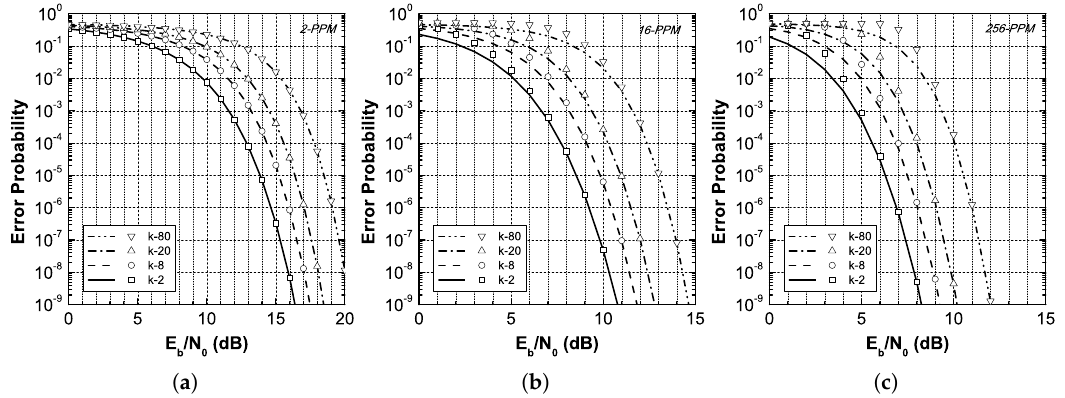
Figure 2. Probability of error (PER) vs. E b / N 0 for Q = 2,16,256. The plot lines and points correspond to the exact and approximated results,